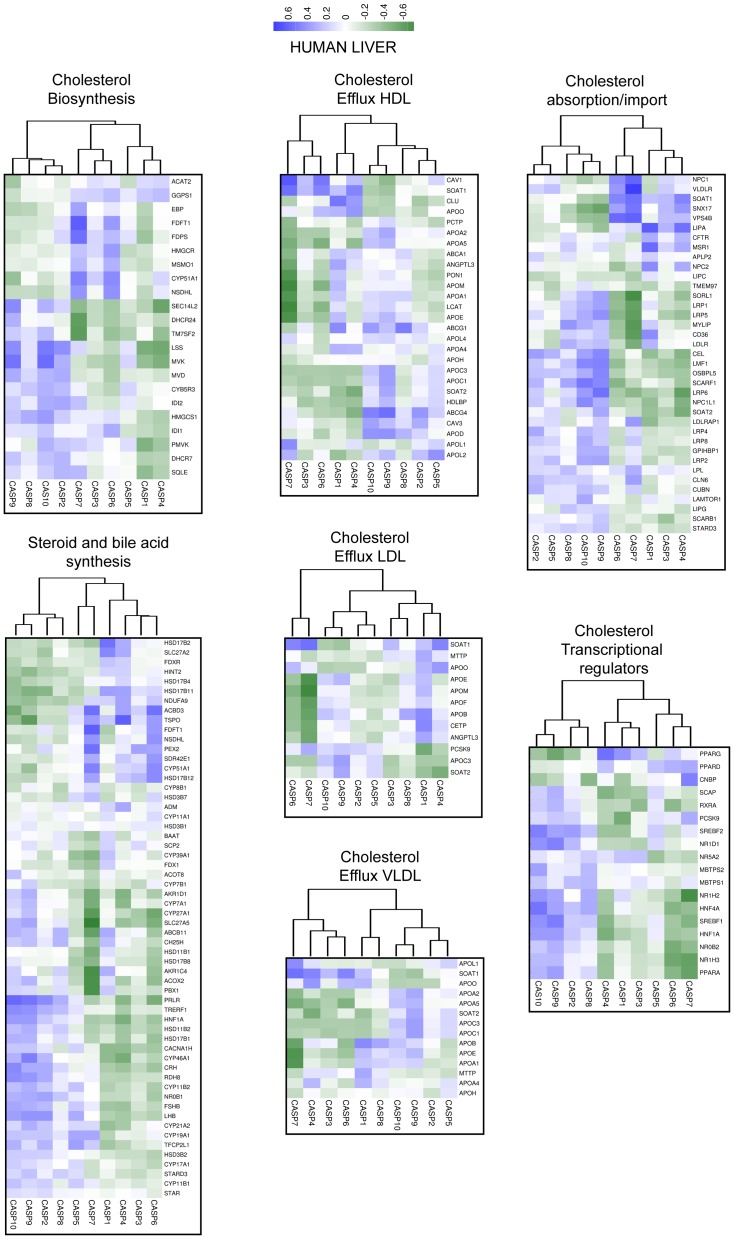
Co-expression analysis of caspases and cholesterol genes in human liver.Correlations of expression levels between caspases and cholesterol genes in different liver samples, for the indicated categories. Data obtained were used to calculate the correlation values with the Pearson method. In the heat map positive values are displayed in blue and negative in dark green. The dendrograms displayed on the top are based on hierarchical clustering using the complete linkage method.